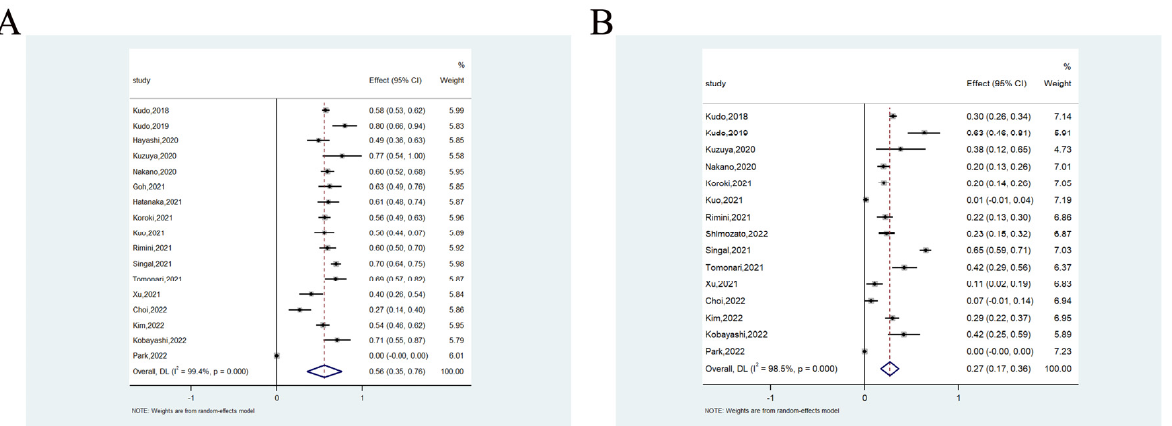
Figure 3. The 1-year OS rate ( A ) and 1-year PFS rate ( B ) of lenvatinib for unresectable hepatocellu- lar